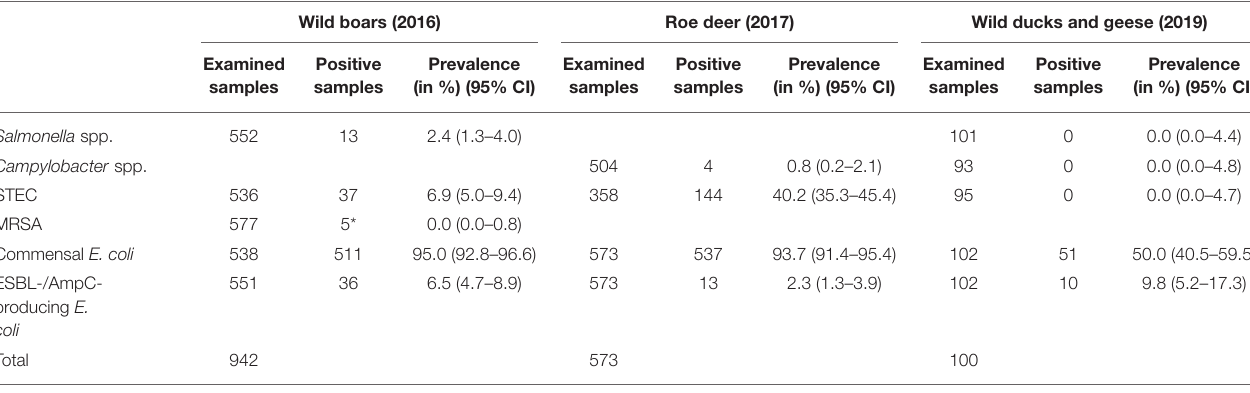
TABLE 3 | Overview of the examined samples and the prevalence and 95% confidence interval (95% CI) of different microorganisms in feces samples ( Salmonella spp., Campylobacter spp., STEC, commensal E. coli , and ESBL-/AmpC-producing E. coli ) and nasal swabs (MRSA) from wild boar, roe deer and wild ducks and geese in 2016, 2017 and 2019, respectively.